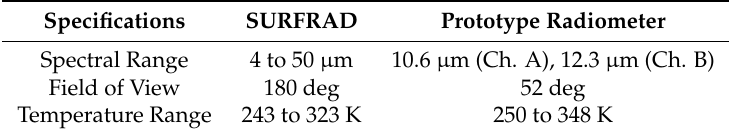
Figure 1. Radiometer spectral response for Channel A and B centered at 10.6 µ m and 12.33 µ m respectively, and for Landsat 8 band 10 and 11 centered at 10.9 µ m and 12.0 µ m, respectively. Table 1. Comparison of the SURFRAD pyrgeometers and the prototype radiometers